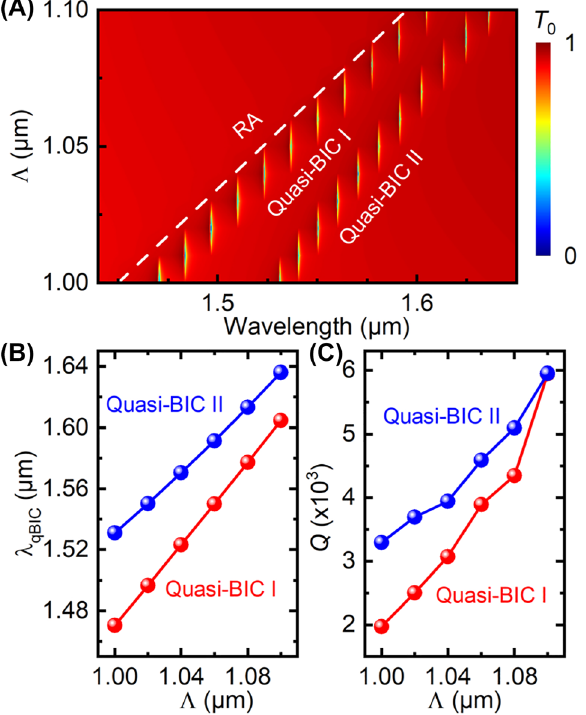
Figure 5: Tuning of the dual-band quasi-BICs via lattice period. (A) Simulated zeroth-order transmittance spectra for different lattice periods. The white dashed line indicates the (0 , ± 1) or ( ± 1 , 0) RA line. (B) Extracted resonance wavelengths and (C) quality factors as functions of Λ